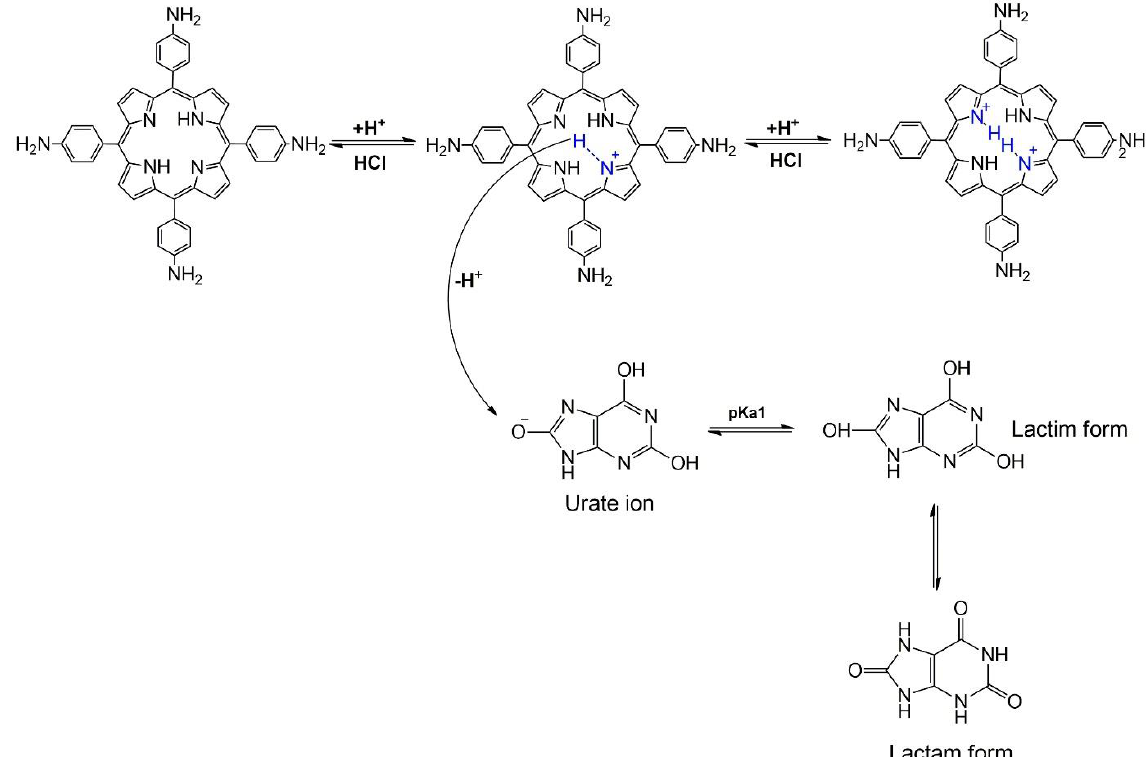
Figure 14. Average percentage errors for UA optical detection using TAmPP, introduced by dif- ferent interferences.